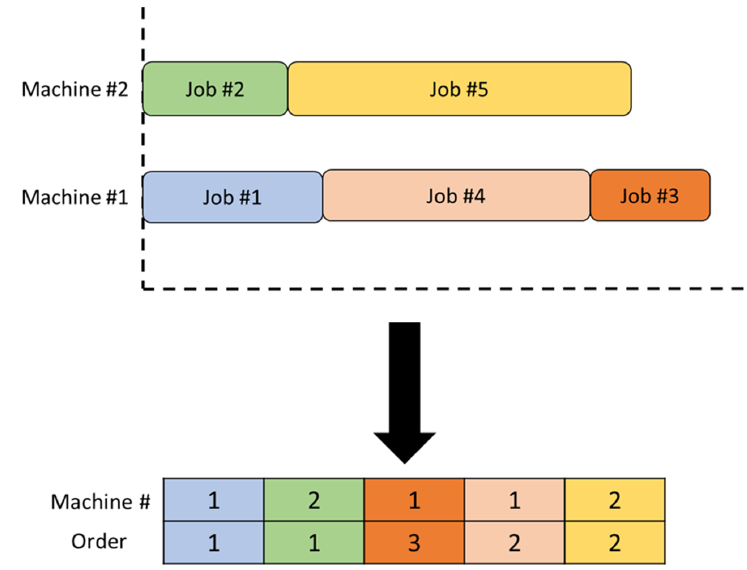
Fig. 1. Representation of